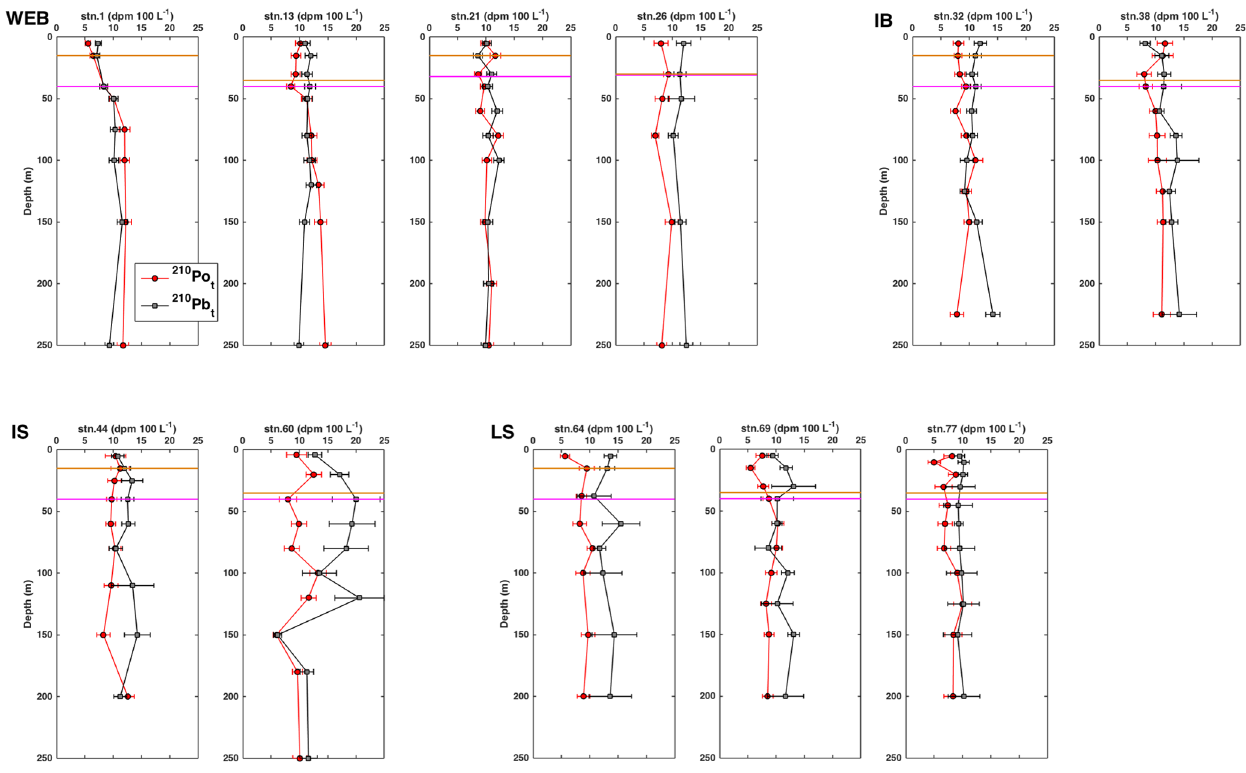
Figure 3. The upper 250m of the depth profiles of total 210 Po ( 210 Po t , red circles) and 210 Pb activities ( 210 Pb t , grey squares) along the GEOVIDE section. The horizontal orange and magenta lines denote the mixed-layer depth (MLD) and the base of the euphotic zone ( Z 1% ), respectively. The depth profiles are shown in the order of sampling and grouped by region (refer to Fig. 2 for the text